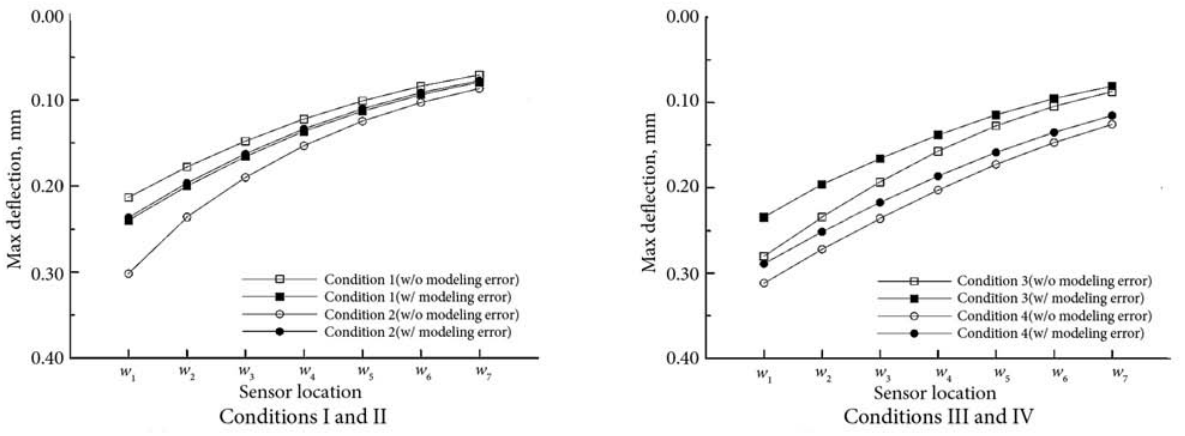
Fig. 6. Max deflection curves with and without modeling errors for integrity conditions for the half space boundary case